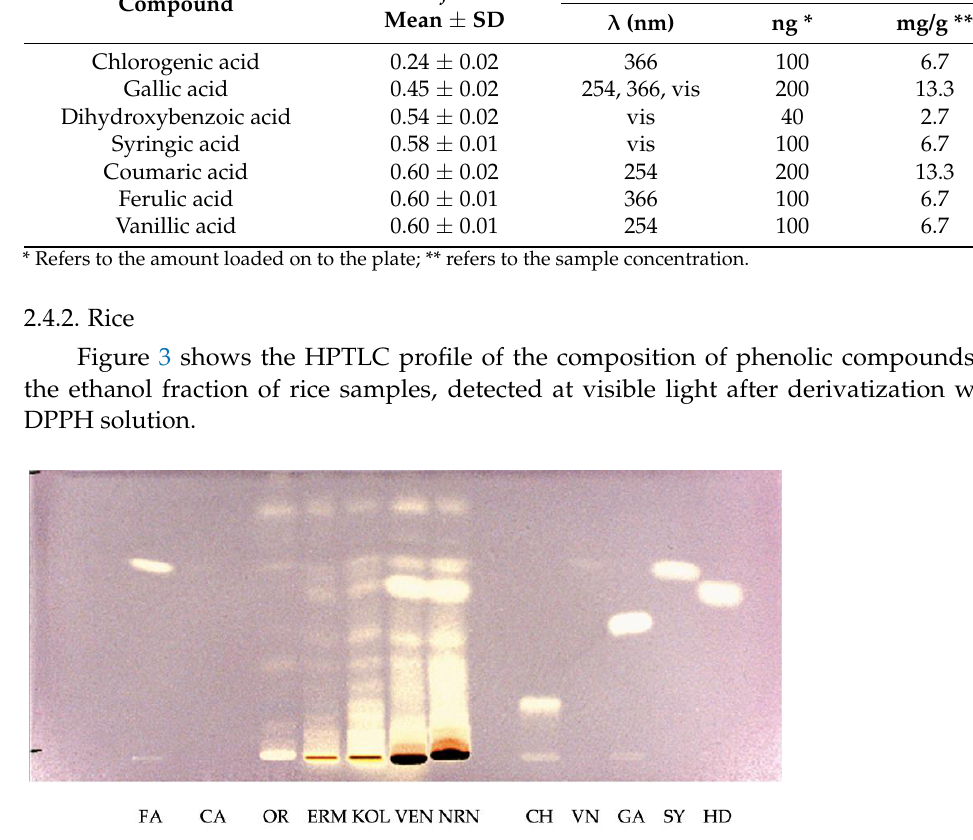
Table 5. Ratio frontis (Rf) and Limit of Detections (LOD) of phenolic acids included in the study. Compound Ratio frontis Compound